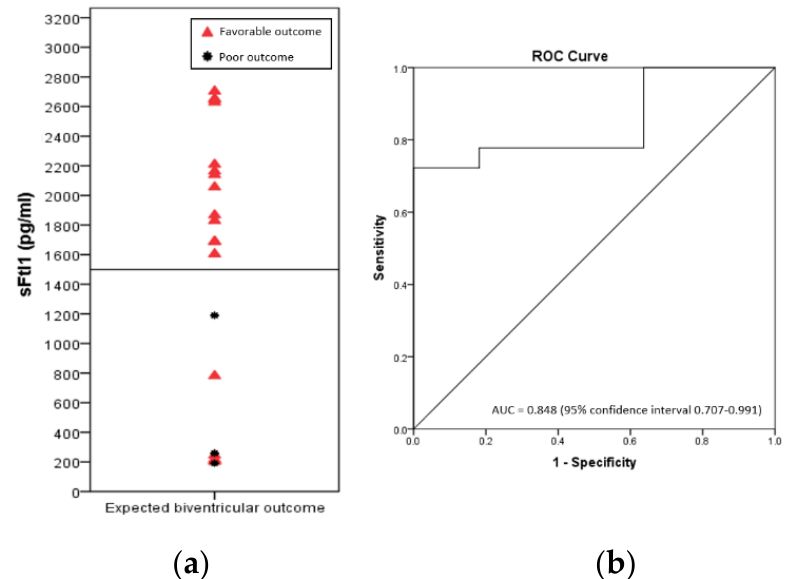
Figure 3. ( a ) Concentrations of soluble fms-like tyrosine kinase-1 (sFlt1) in the cord blood of control fetuses and fetuses with expected biventricular repair, classified according to outcome (red triangle, favorable outcome; black star, poor outcome. Reference line set at 1520.7 pg/mL identified at ( b ) ROC curve for sFlt1 as a predictor of favorable outcome in fetuses with expected biventricular